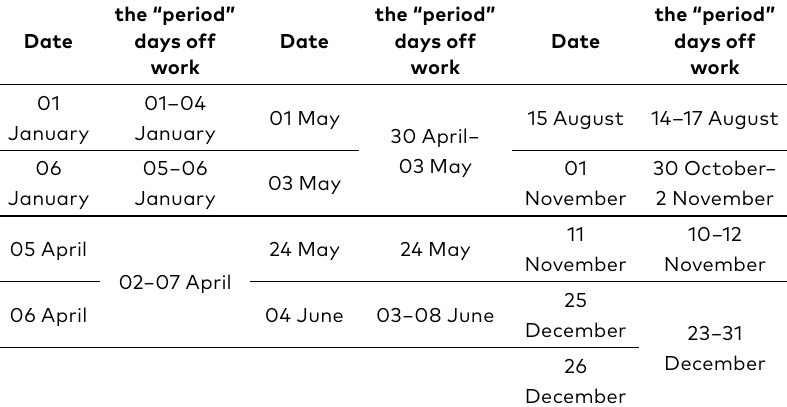
Figure 1. Map of places of automatic traffic recording stations in Poland by the General Directorate for National Roads and Motorways of Poland Table 1. The list of public holidays and related dates in 2015